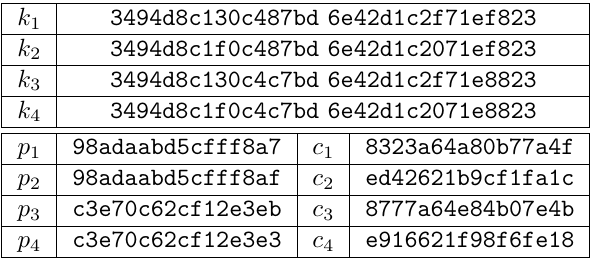
Table 22: A right quartet satisfying the boomerang distinguisher I for 18 rounds of SKINNY